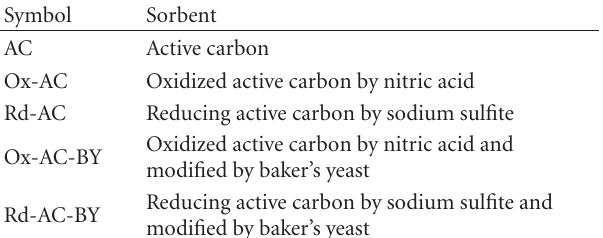
Table 1: Hybrid chemically and biologically modified-active car- bon